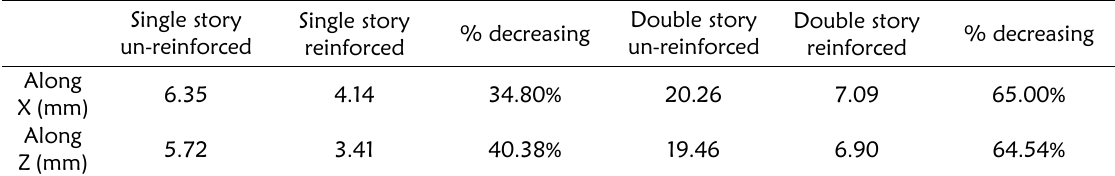
Table 2: Displacements from equivalent static force analysis